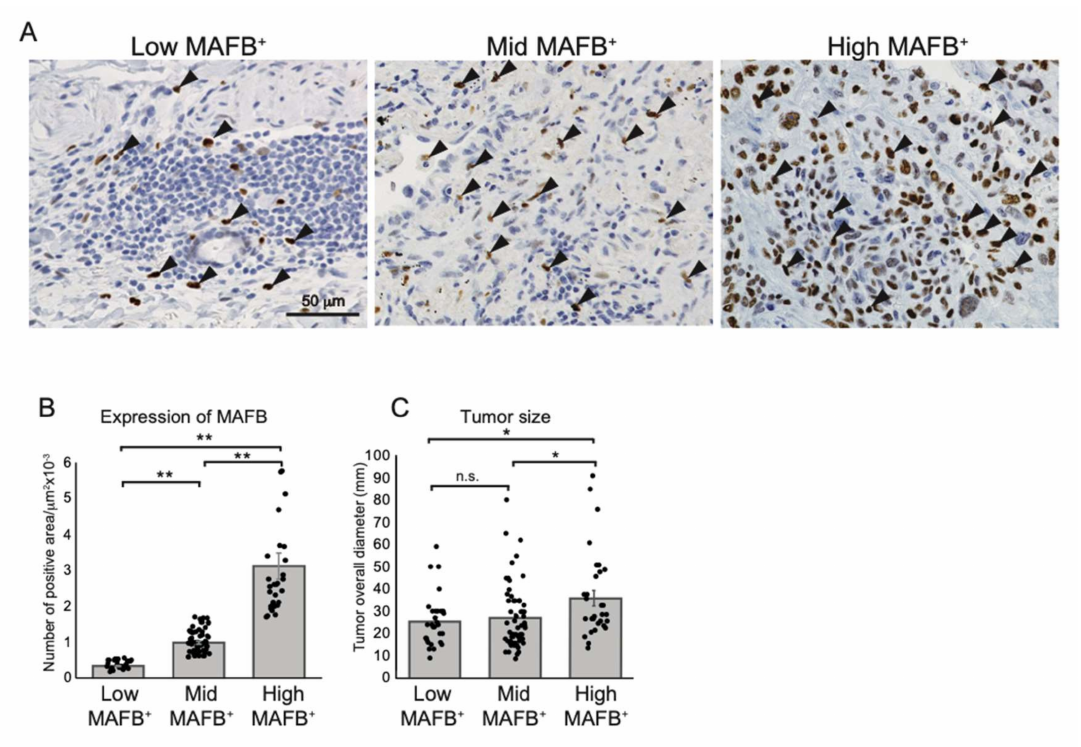
Figure 2. Grouping non-metastatic lung adenocarcinoma tissue according to MAFB + cells density. ( A ) Representative data of immunohistochemical analysis of human lung adenocarcinomas with anti-human MAFB. Arrows point out the MAFB-positive cells. ( B ) MAFB-positive area relative to tissue area (MAFB/tissue area) was morphometrically quantified. Tissue samples were grouped into top 25% (high-MAFB + group, MAFB expression area/tissue area = 0–0.005 ( n = 30)), 25–50% (mid-MAFB + group, MAFB expression area/tissue area = 0.006–0.016 ( n = 59)), and bottom 25% (low-MAFB + group, MAFB expression area/tissue area = 0.017–0.121 ( n = 31)). ( C ) MAFB expression in three groups was tested for correlation to tumor sizes. Data are presented as means ± SEM; data is considered significant at * p < 0.05, ** p < 0.01. Table 1. Correlation between MAFB + cell density and the clinicopathological factors in non-metastatic lung